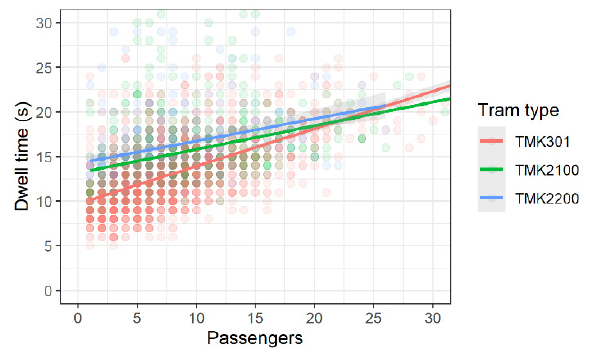
Figure 11. Dependence of dwell time on the number of passengers.